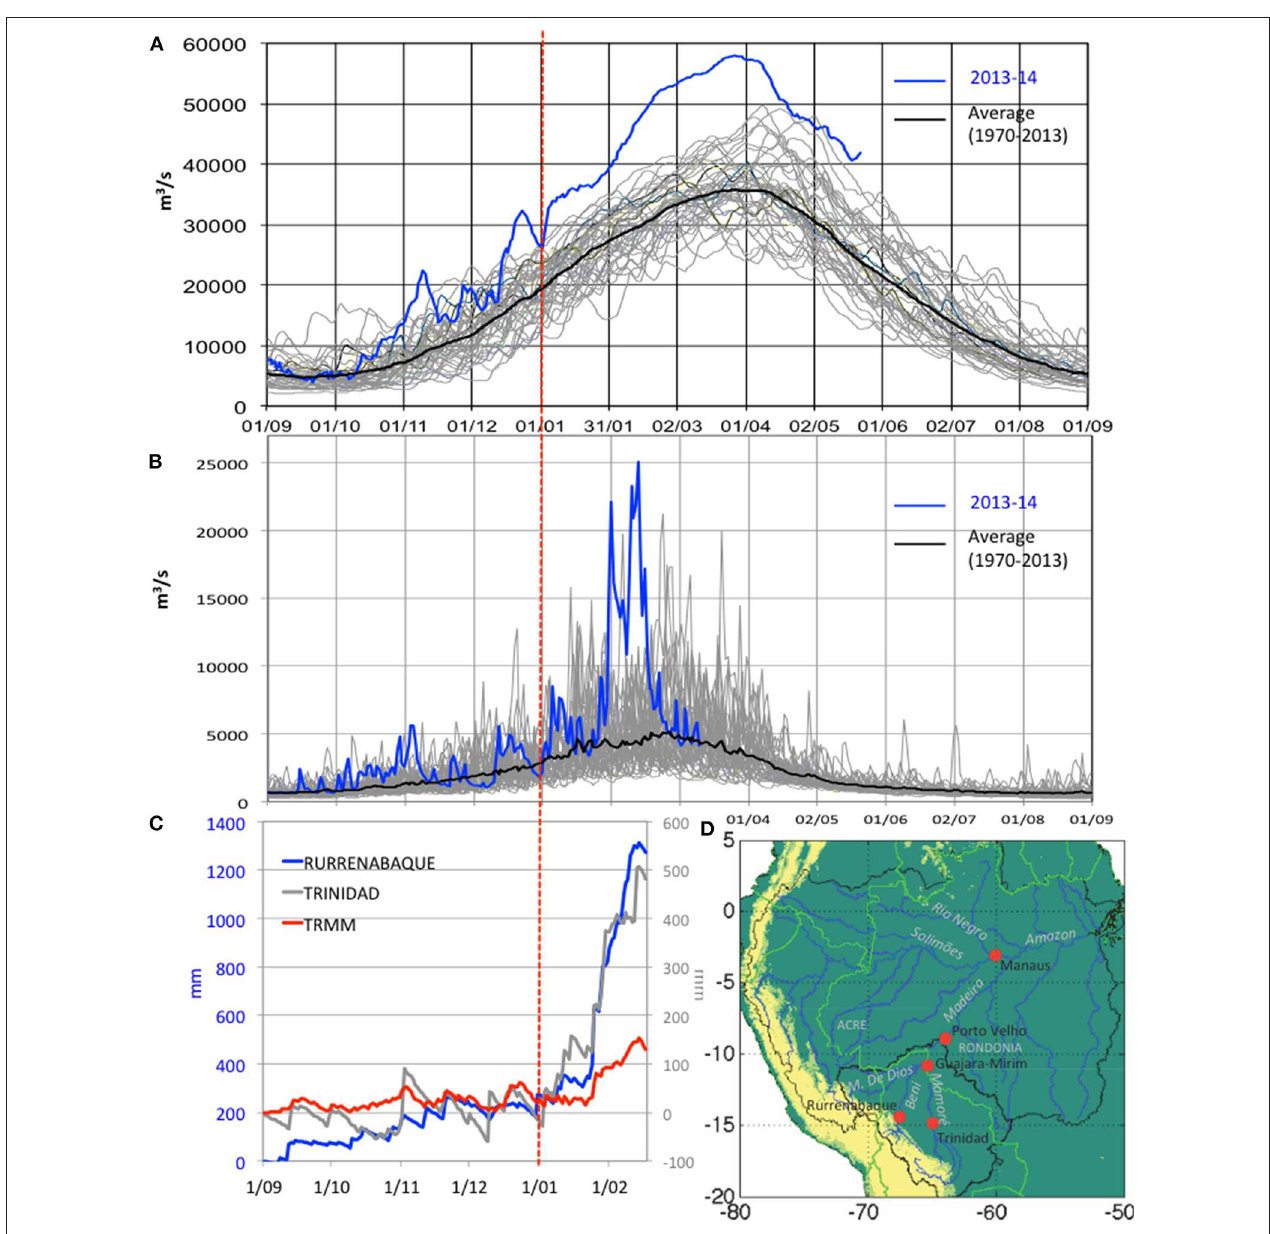
FIGURE 13 | Daily discharge at (A) Porto Velho on the upper Madeira River, and (B) Rurrenabaque on the upper Beni River during the period of 1970–2013 (gray lines). Mean discharge values and discharge during the 2013–14 hydrological year are displayed in black and blue lines, respectively. (C) Cumulative rainfall anomalies in Rurrenabaque (blue, left Y axis) and Trinidad (gray, right Y axis), and area average rainfall in the Porto Velho River basin computed with TRMM-RT 3B42 V7 (red, right Y axis), for the 01/09/2013–17/02/2014 period. (D) Location of stations and main rivers. Adapted from Espinoza et al. (2014). © ERL. CC